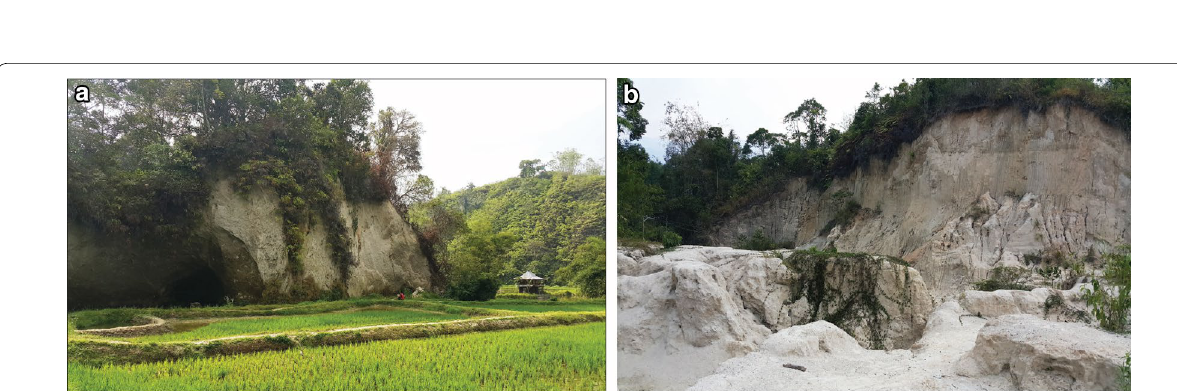
Fig. 5 Examples of exposures of the proximal Ranau Tuff within 10 km of the eruptive center. a South of Ranau Lake within the Liwa Valley, b North of Ranau Lake within the Kumering River